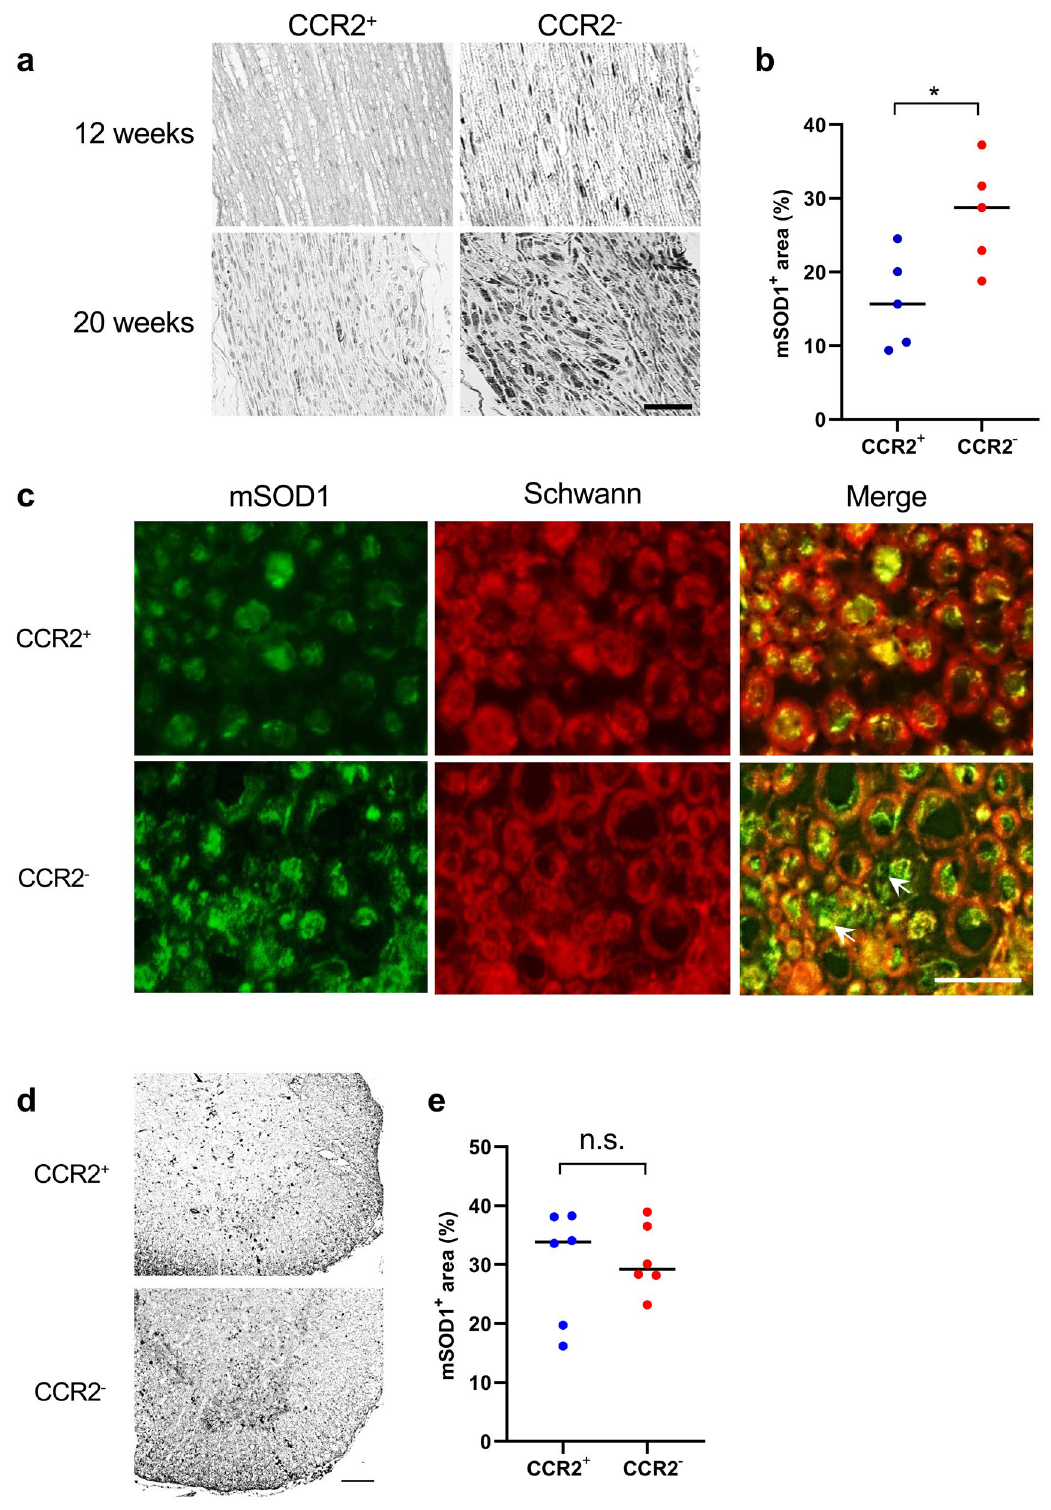
Figure 4. Aggravation of mSOD1 accumulation in the nerve by CCR2 ablation. ( a ) Immunostaining for mSOD1 in the sciatic nerves of CCR2-deficient SOD1 G93A mice and CCR2-positive littermates. ( b ) Accumulation of mSOD1 protein was significantly increased in CCR2-deficient SOD1 G93A mice than in CCR2-positive SOD1 G93A mice at 12 weeks of age ( p = 0.032, n = 5). ( c ) Double immunostaining for mSOD1 and Schwann cells indicated a greater accumulation of mSOD1 protein in the sciatic nerves of CCR2-deficient SOD1 G93A mice showing an overflow of mSOD1 protein from Schwann cells and in the myelin sheath (arrows) compared with CCR2-positive SOD1 G93A mice at 12 weeks of age. ( d ) Immunostaining for mSOD1 protein in the lumbar spinal cord of CCR2-deficient SOD1 G93A mice and CCR2-positive littermates at 12 weeks of age. ( e ) There was no difference in the mSOD1 + area (%) between the two mouse genotypes at 12 weeks of age ( p = 0.85, n = 6). The unpaired t test was used for statistical comparisons. Scale bars: ( a ) 20 μm; ( c ) 10 μm; ( d ) 100 μm. * p < 0.05. n.s. = not